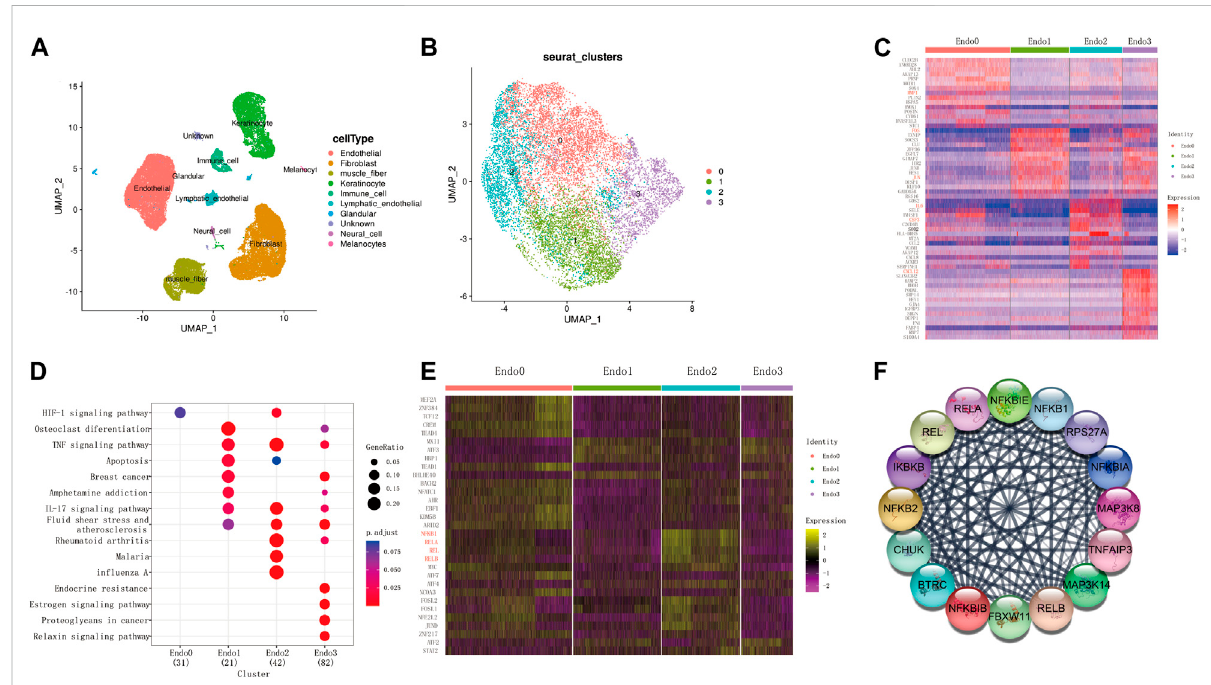
FIGURE 1 Single-cell transcriptome identi fi es four subpopulations of keloidal vascular endothelial cells. (A) UMAP two-dimensional scatter plot of the GSE163973 keloid single cell dataset after dimensional reduction and clustering. (B) Endothelial cells can be divided into four subpopulations. (C) Top20 differentially expressed genes for the four endothelial cell subpopulations (wilcoxon-test, log2FC > 0.05, adj. p < 0.05). (D) Functional enrichment analysis of highly expressed genes from each subpopulation. (E) Transcription factor enrichment analysis (wilcoxon-test, log2FC